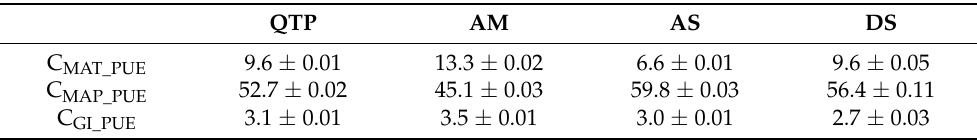
Table 4. Means (±SE) of the relative contributions (%) of mean annual temperature (C MAT_PUE ), mean annual precipitation (C MAP_PUE ), and grazing intensity (C GI_PUE ) to PUE variation estimated by the generalized linear model (GLM) across the entire QTP and within alpine meadow (AM), alpine steppe (AS), and desert steppe (DS).